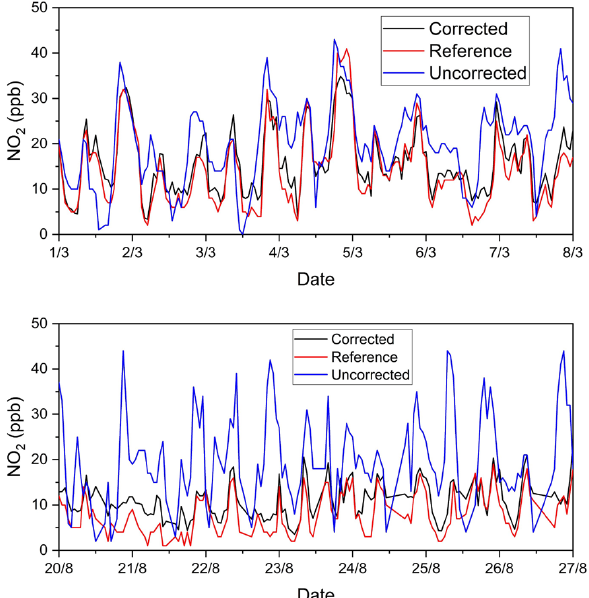
Figure 4. Time series of NO 2 concentrations for two 7-day periods of the test set (2022). Uncorrected NO 2 low-cost sensor reading is displayed with blue lines, RF-corrected NO 2 values are displayed with black lines, and reference NO 2 concentrations are displayed with red lines.